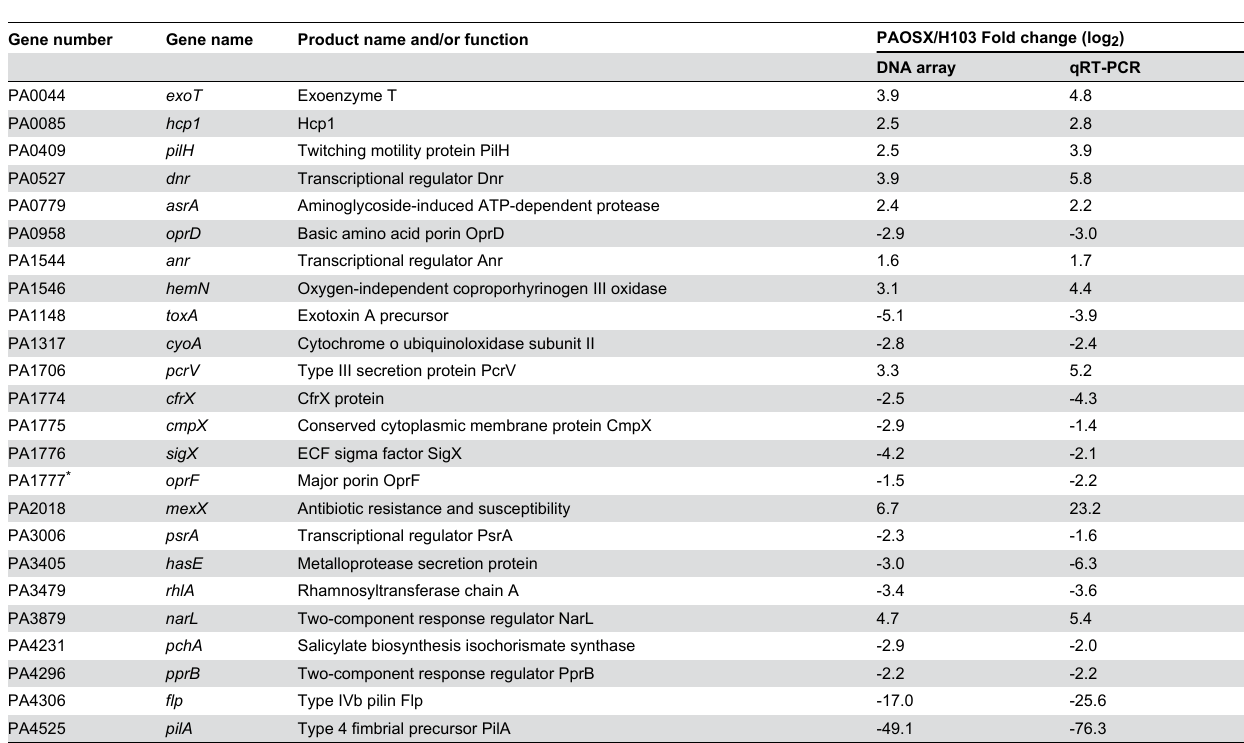
Table 1. Selected genes used for validation of the microarray data by